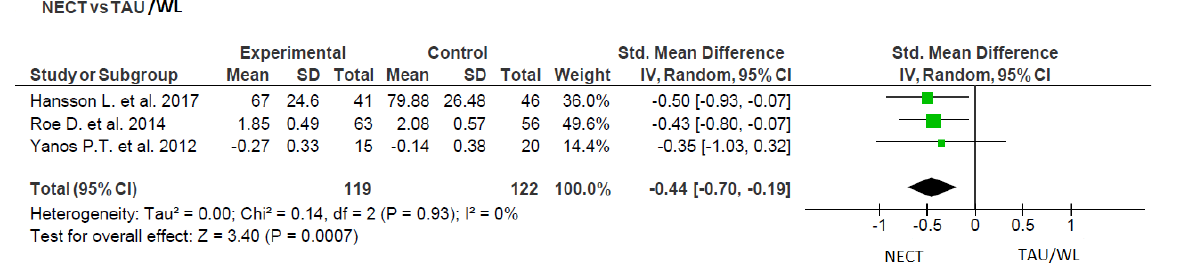
Figure 3. Subgroup analysis of Narrative Enhancement and Cognitive Therapy (NECT) in compar- ison to Treatment as Usual (TAU) or the Waiting List (WL) [33,34,48].